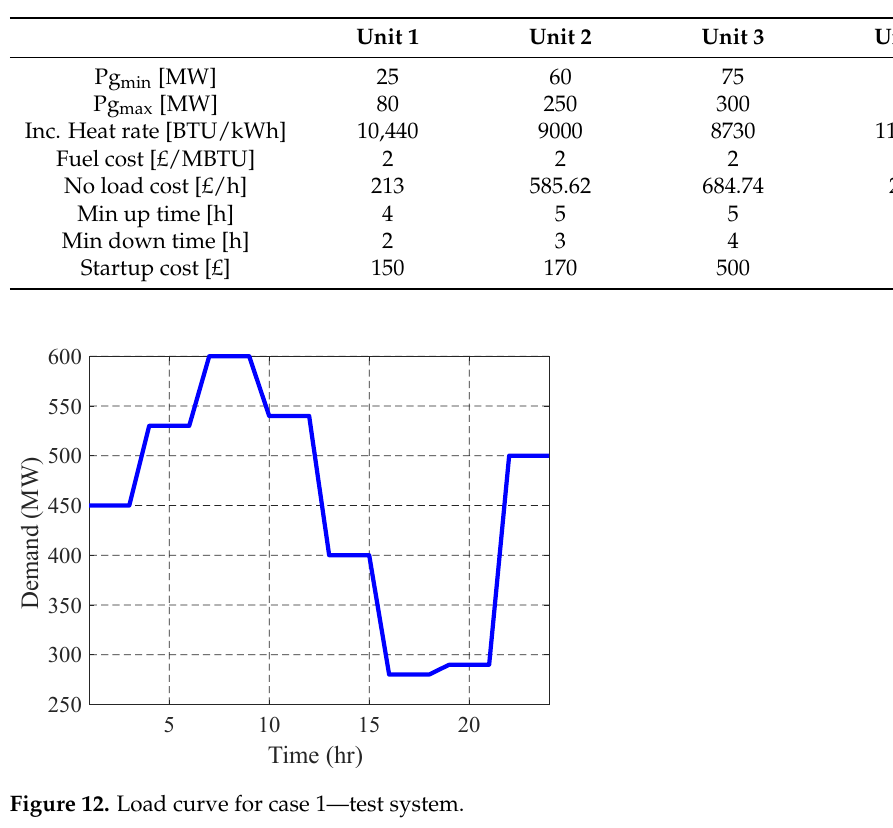
Figure 12. Load curve for case 1—test system.